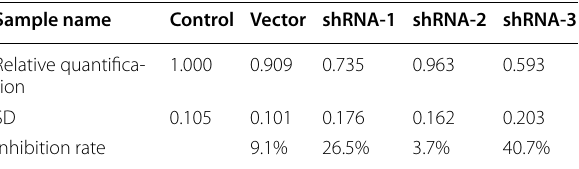
Table 7 Inhibition of NDUFV2 gene silencing on the proliferation of MCF-7/ADR cells: the relative quantitative and inhibition rate of NDUFV2 in each group of MCF-7/ADR x ± s , n = 3